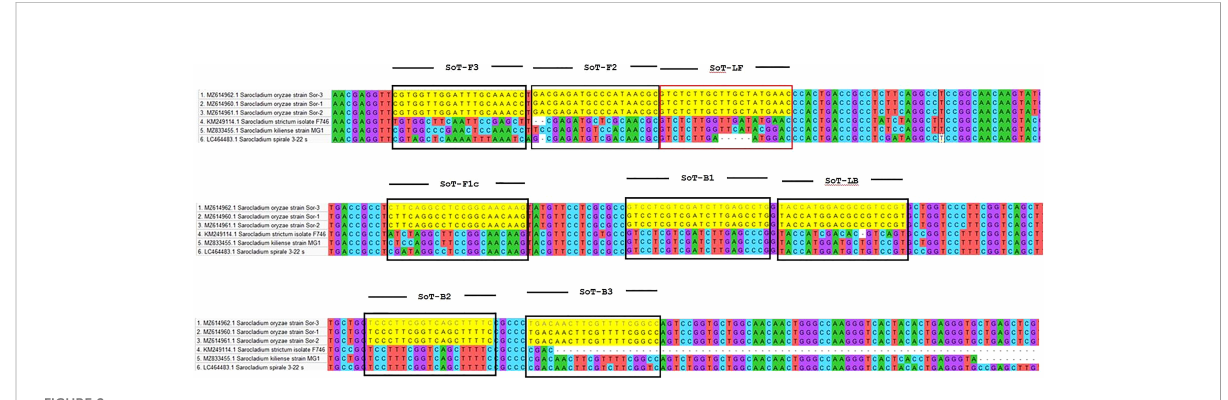
FIGURE 2 Comparison of the b -tubulin region of S. oryzae with other Sarocladium